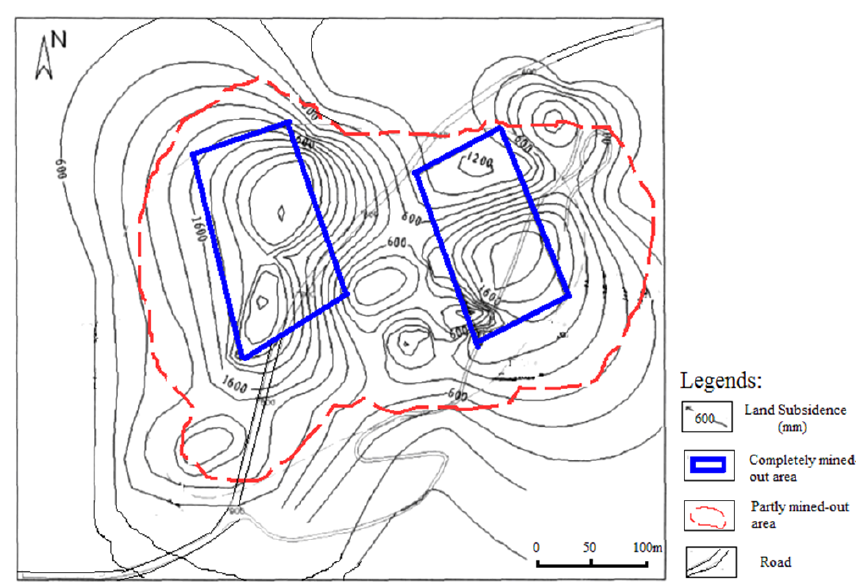
Figure 6. One of the typical maps of mining intensity and risk ranks based on